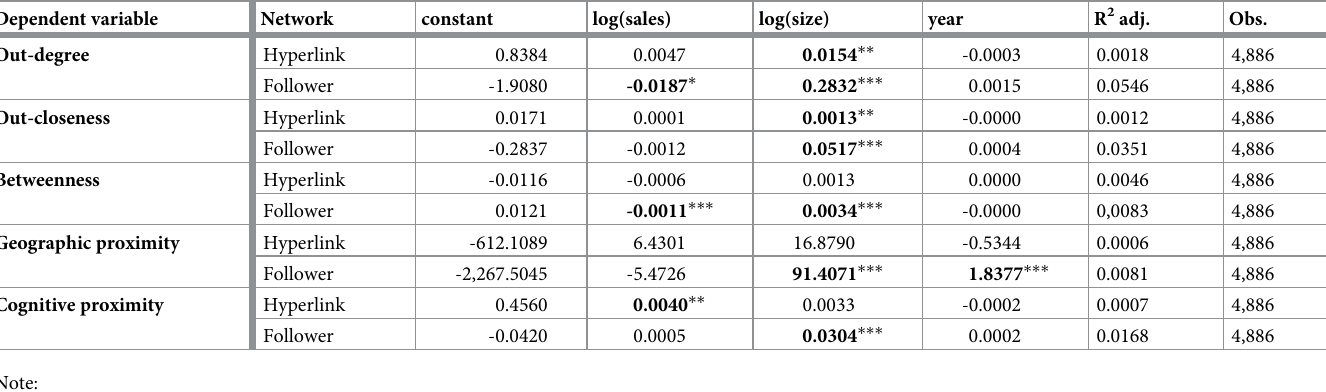
Table 3. Influence of company characteristics in the Hyperlink and Follower